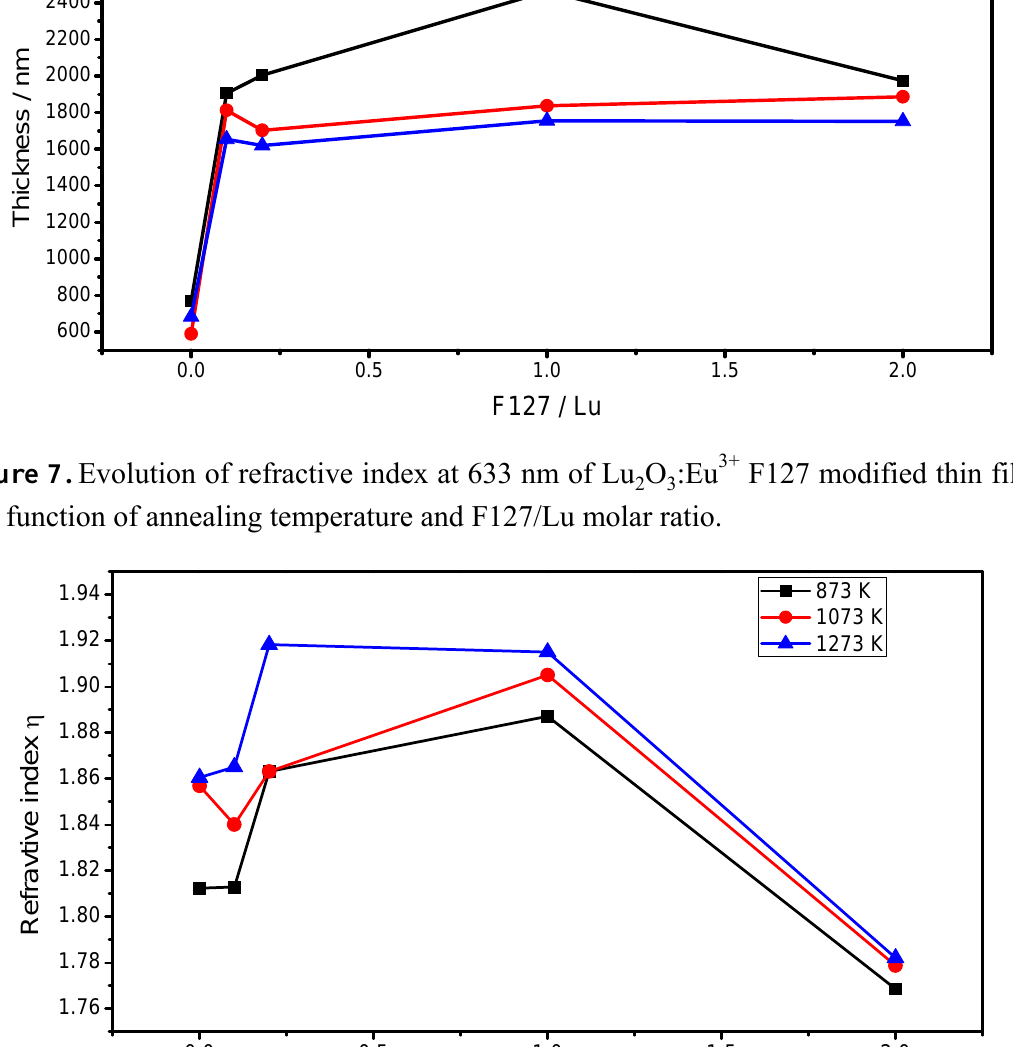
Figure 6. Evolution of thickness of Lu annealing temperature and F127/Lu molar ratio.